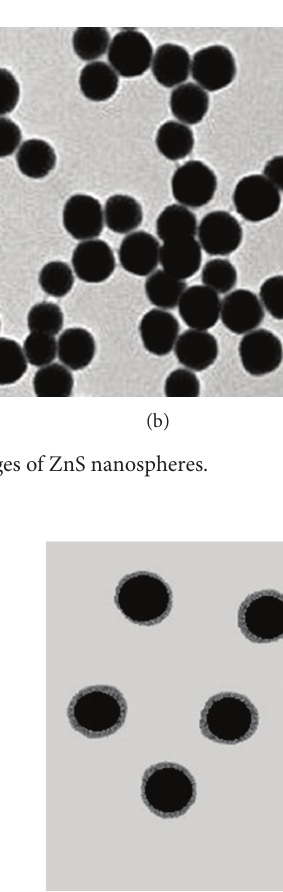
Figure 4: TEM image of ZnS@SiO 2 core-shell